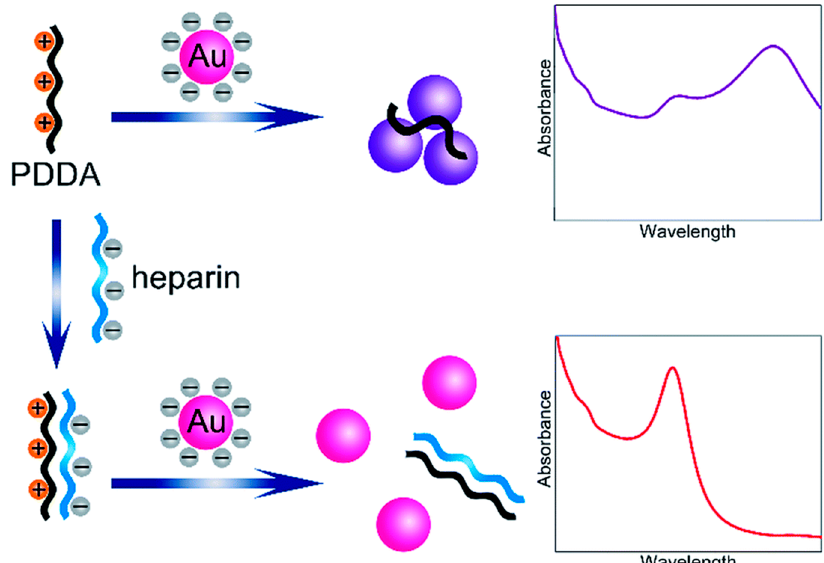
Figure 7. The schematic illustration of heparin detection using a label-free colorimetric method. After the addition of poly(diallyldimethylammonium chloride) (PDDAs), AuNPs aggregate due to attractive electrostatic interactions between the PDDA and the AuNPs. However, when heparin is present, the PDDA molecules will interact with the heparin, which prevents the PDDA-induced aggregation of the AuNPs. Reproduced with permission from Reference [76]. Royal Society of Chemistry, 2019.